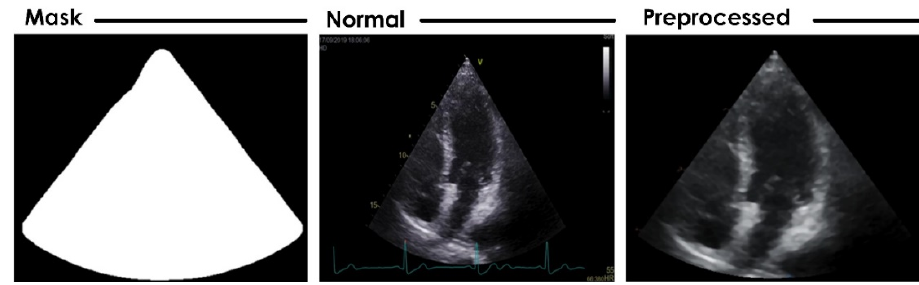
Figure 4. Preprocessed image derived by creating a mask.